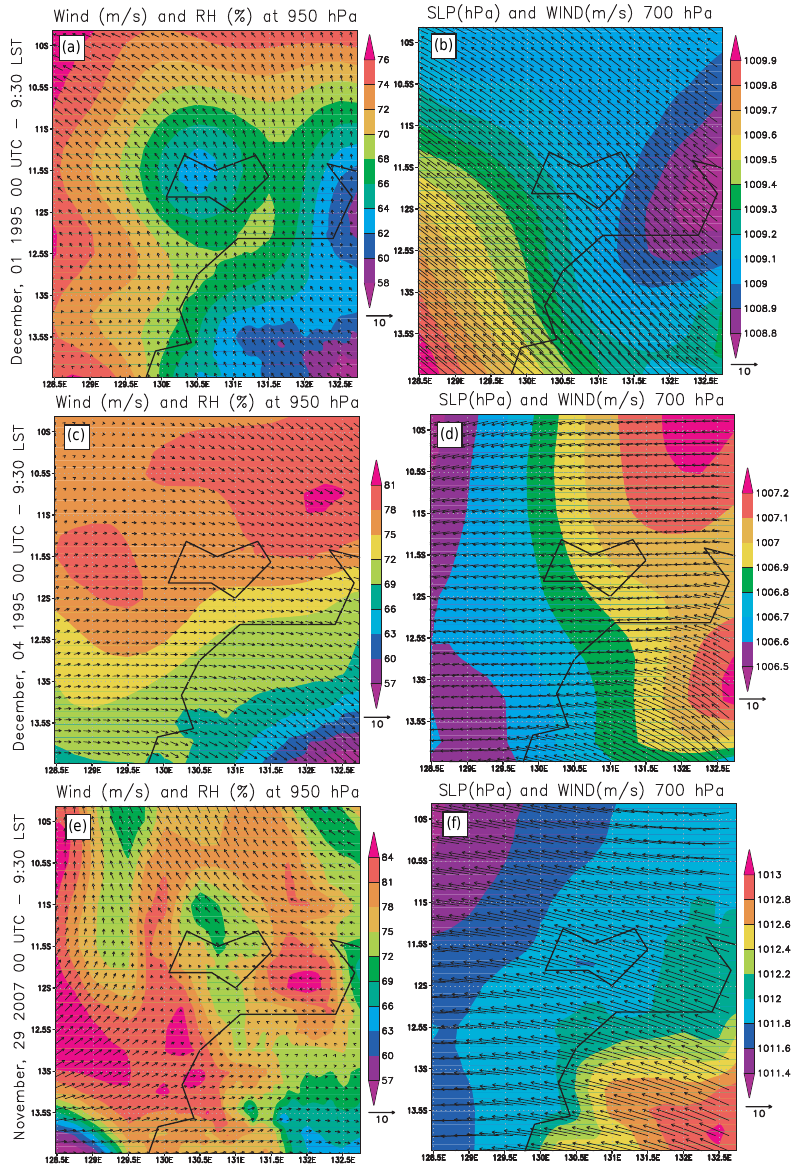
Figure 1. ECMWF analysis over the Tiwi Islands at 00:00UTC for D1, D4 and N29. Panels (a, c, e) report surface wind and relative humidity at 950hPa; panels (b, d, f) report sea level pressure in filled contours and wind flow vectors at